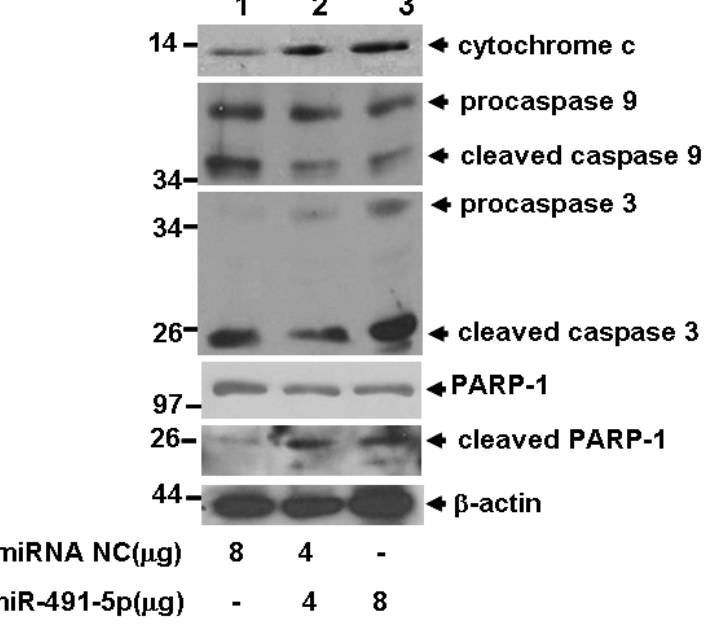
Figure 7. miR491-5p mediated cell apoptosis was associated with mitochrondia mediated intrinsic pathway. The cell lysates prepared from miR491-5p transfected SW1990